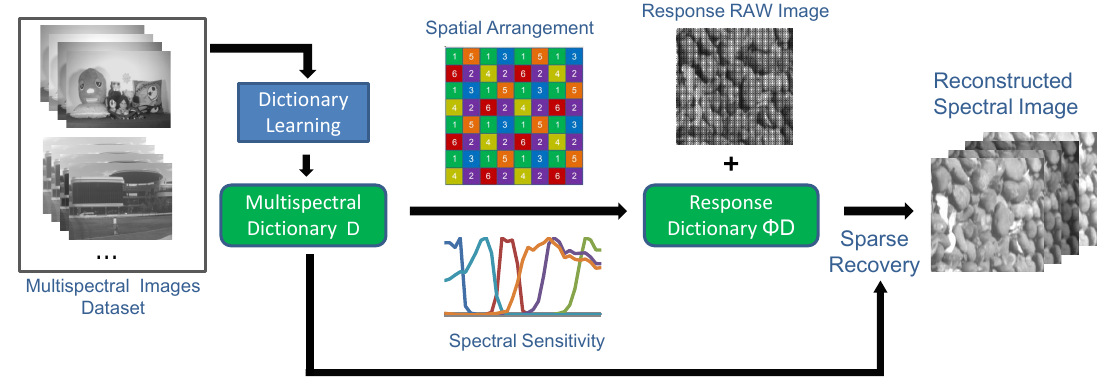
Figure 2. The flowchart of our spectral